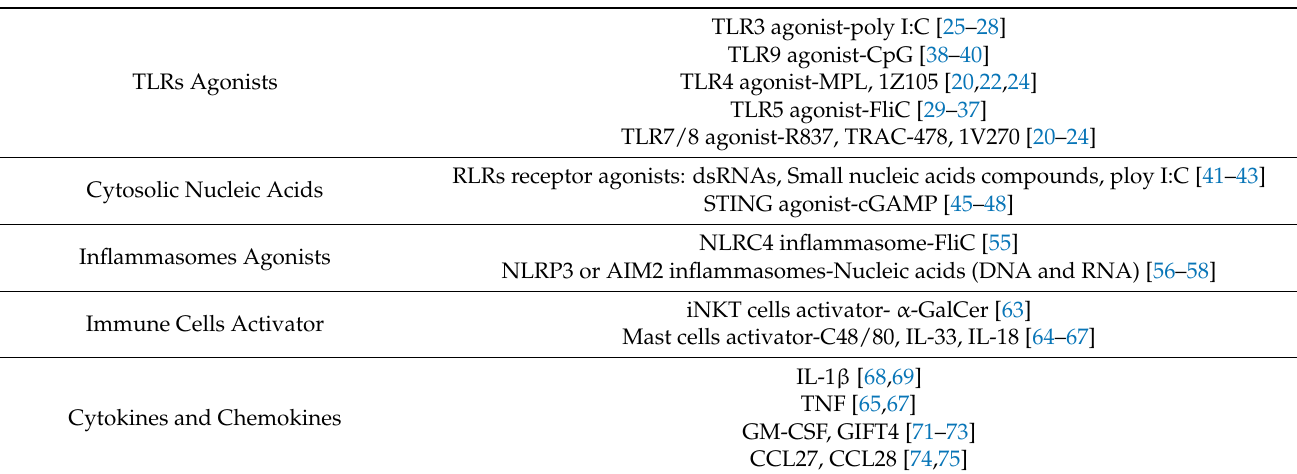
Table 2. Potential influenza adjuvants base on immune